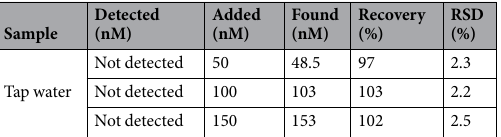
Table 1. Hg(II) ion concentrations found in tap water samples using the standard addition method, and the recoveries and relative standard deviations (RSDs) of the Hg(II)